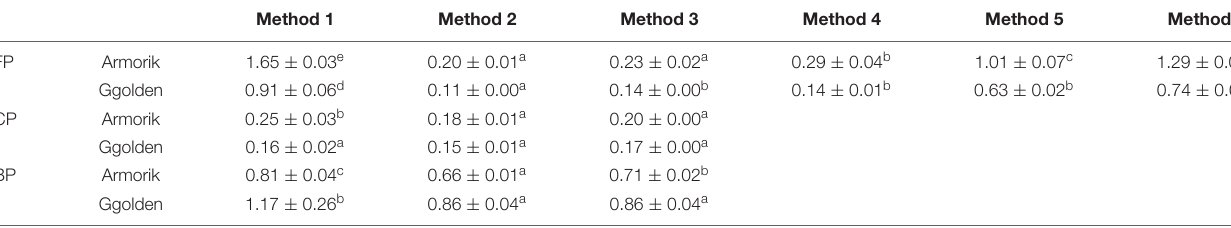
TABLE 2 | Total phenolic content (TPC) of the free, conjugated, and bound PA from different extraction methods.